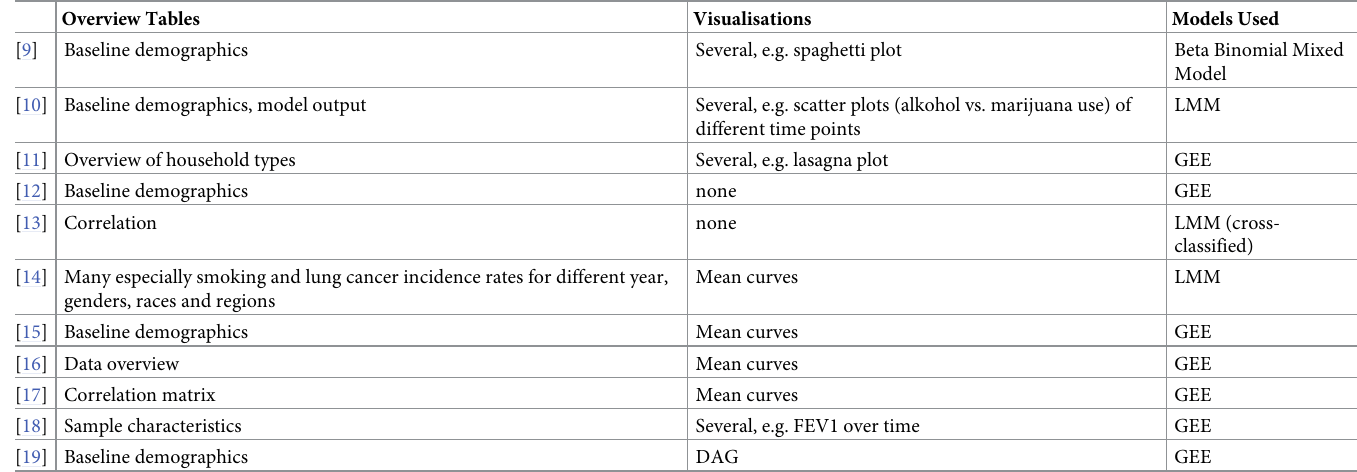
Table 2. Which statistical methods were used by the papers?.